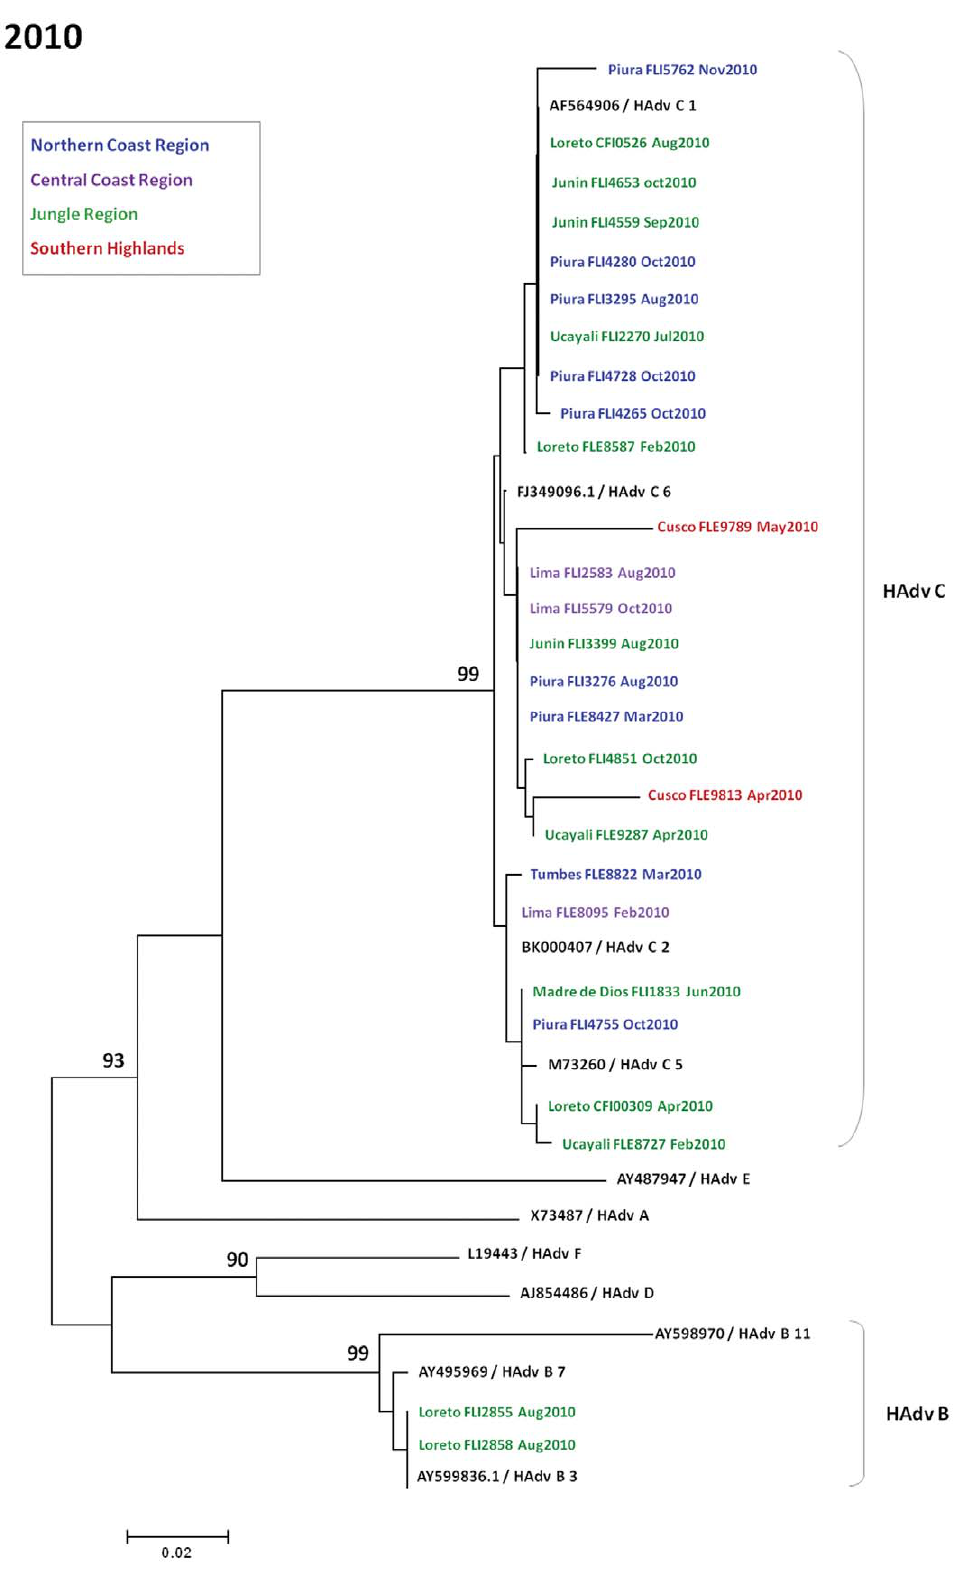
Figure 8. Phylogenetic tree of adenovirus isolates in Peru during 2010.